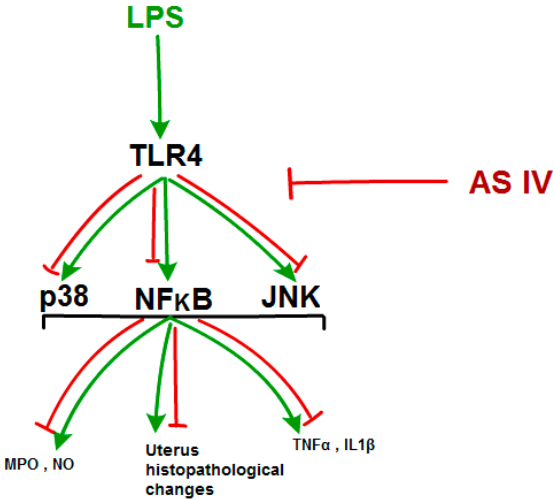
Figure 10. A putative mechanism of Astragaloside IV alleviating LPS-induced endometritis in mice. Green arrows indicate the effects of LPS on the uterus and red arrows indicate the protective effects of Astragaloside IV on uteri containing LPS-induced endometritis.